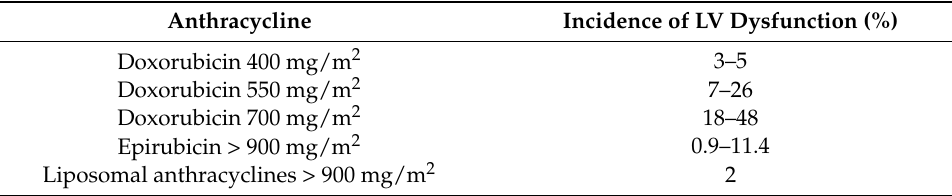
Table 4. Different dosages of anthracyclines and incidence of left ventricular dysfunction [13]. Anthracycline Incidence of LV Dysfunction (%) Doxorubicin 400 mg/m 2 3–5 Doxorubicin 550 mg/m 2 7–26 Doxorubicin 700 mg/m 2 18–48 Epirubicin > 900 mg/m 2 0.9–11.4 Liposomal anthracyclines > 900 mg/m 2